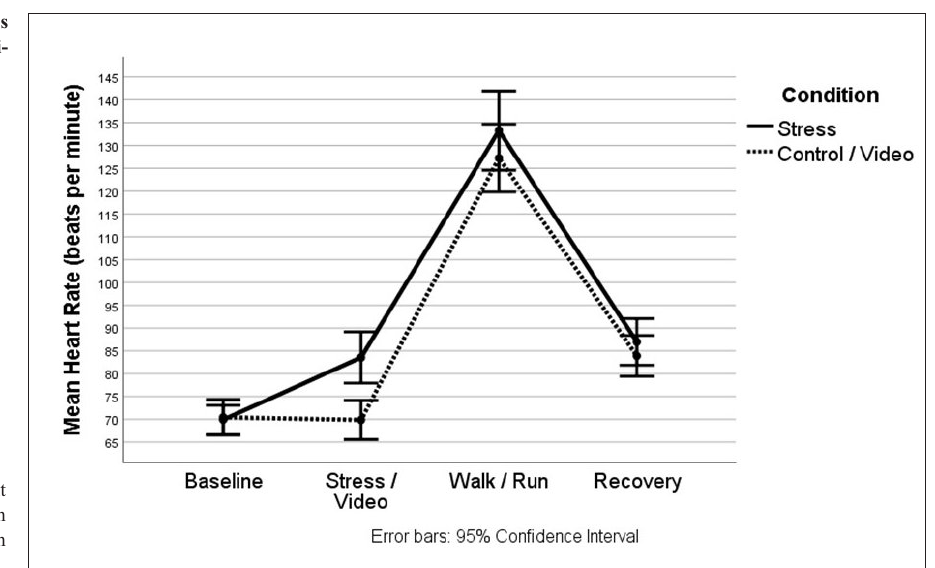
Figure 2. Heart rate profiles in two experimental condi-